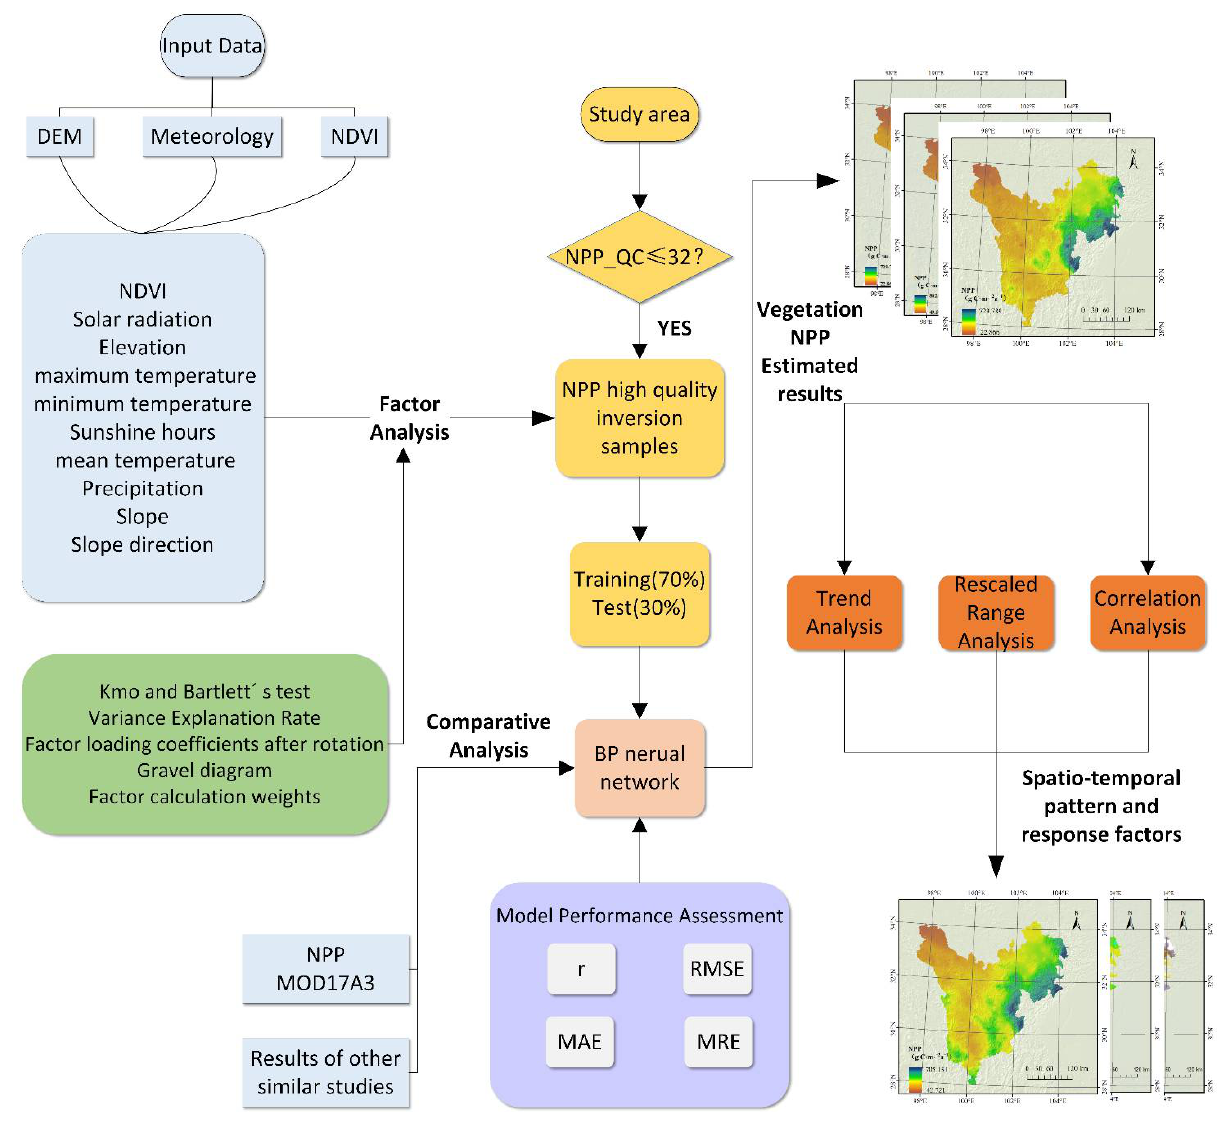
Figure 3. Flowchart of NPP estimation and analysis.